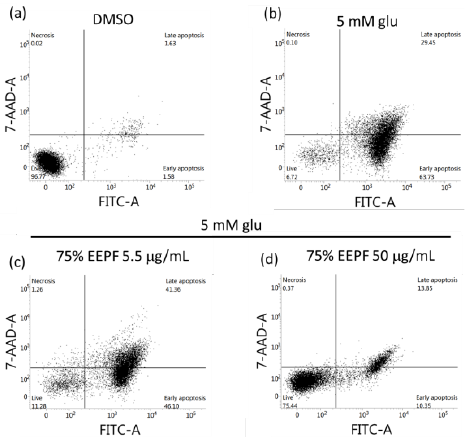
Figure 3. Apoptosis analysis by flow cytometry. HT22 cells were treated with glutamate and 75% EEPF for 18 h and flow cytometry was performed. ( a ) DMSO control shows 96.77% live cells. ( b ) 5 mM glutamate treated wells shows only 6.72% live cells and 93.18% cells has undergone apoptotic cell death. ( c ), ( d ) The 75% EEPF co-treatment has significantly suppressed the apoptosis at 50 µ g/mL but failed suppress at low concentration 5.5 µ g/mL.